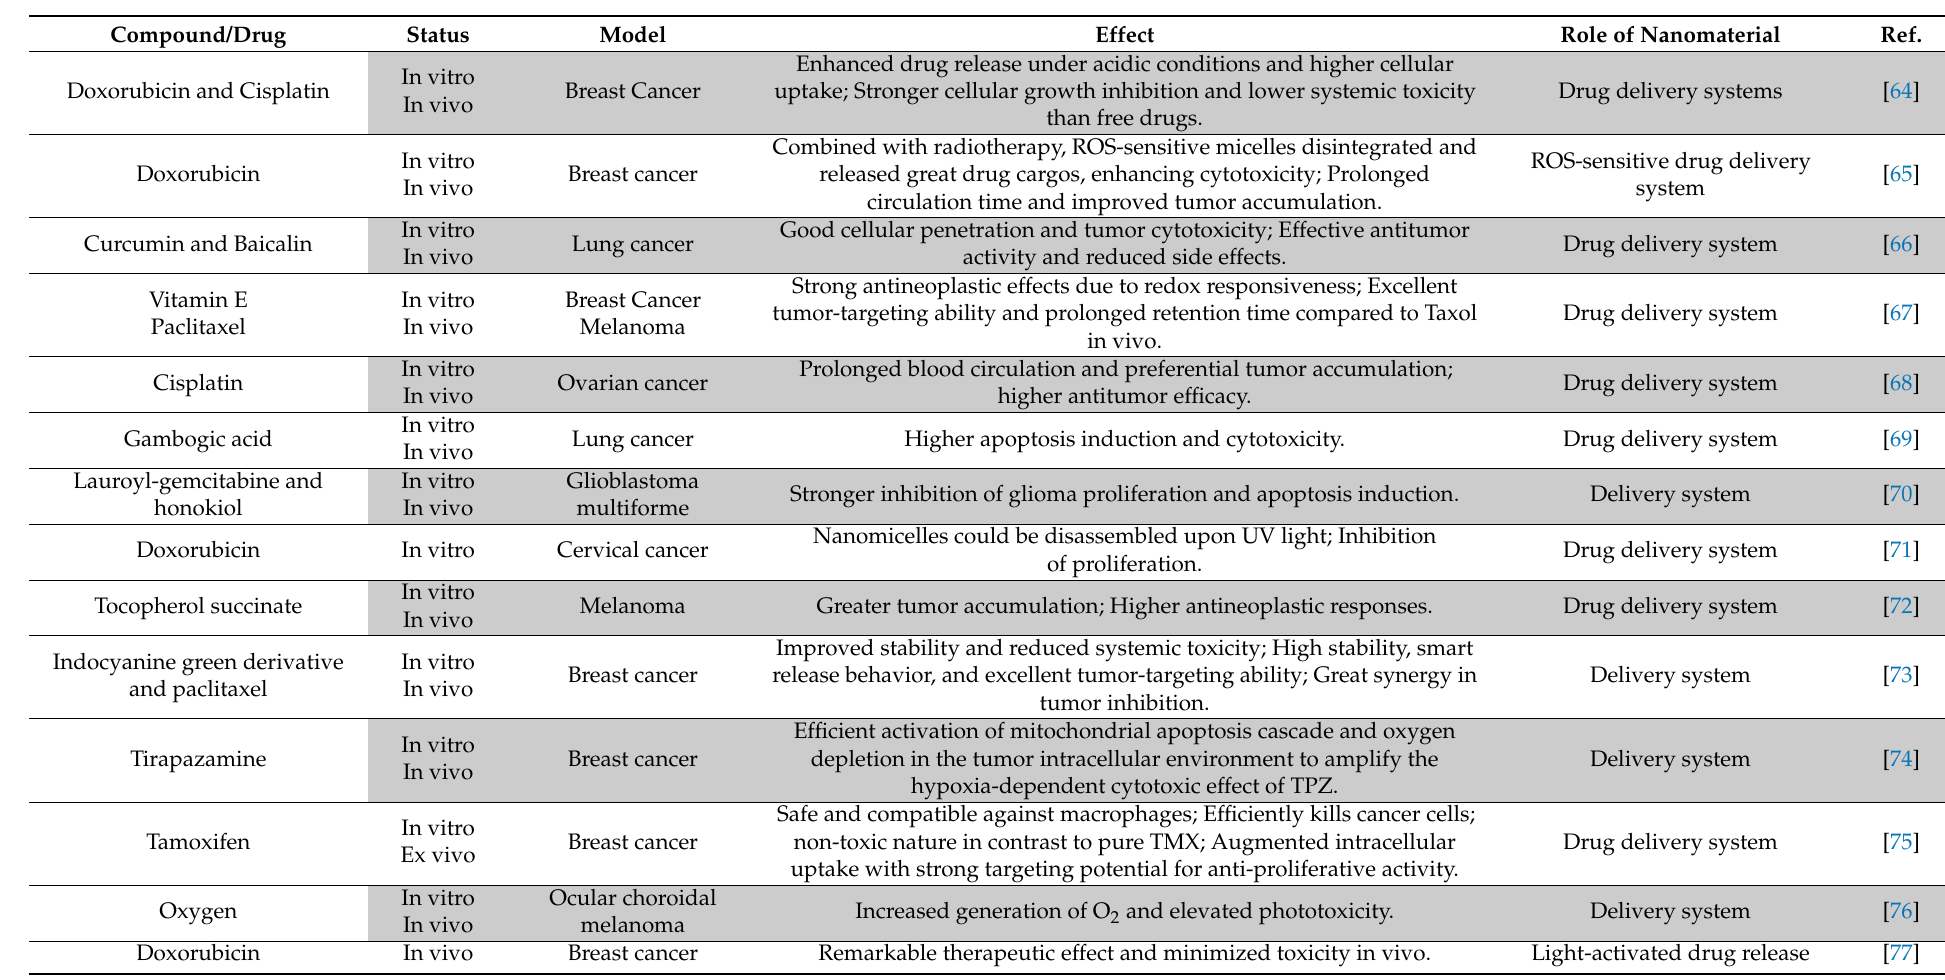
Table 3. Recent application of HA-based micelles in cancer